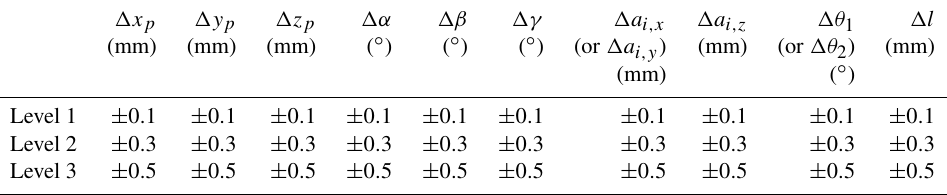
Table 5. Levels division of L 27 (3 10 ) array for geometric tolerance factors.